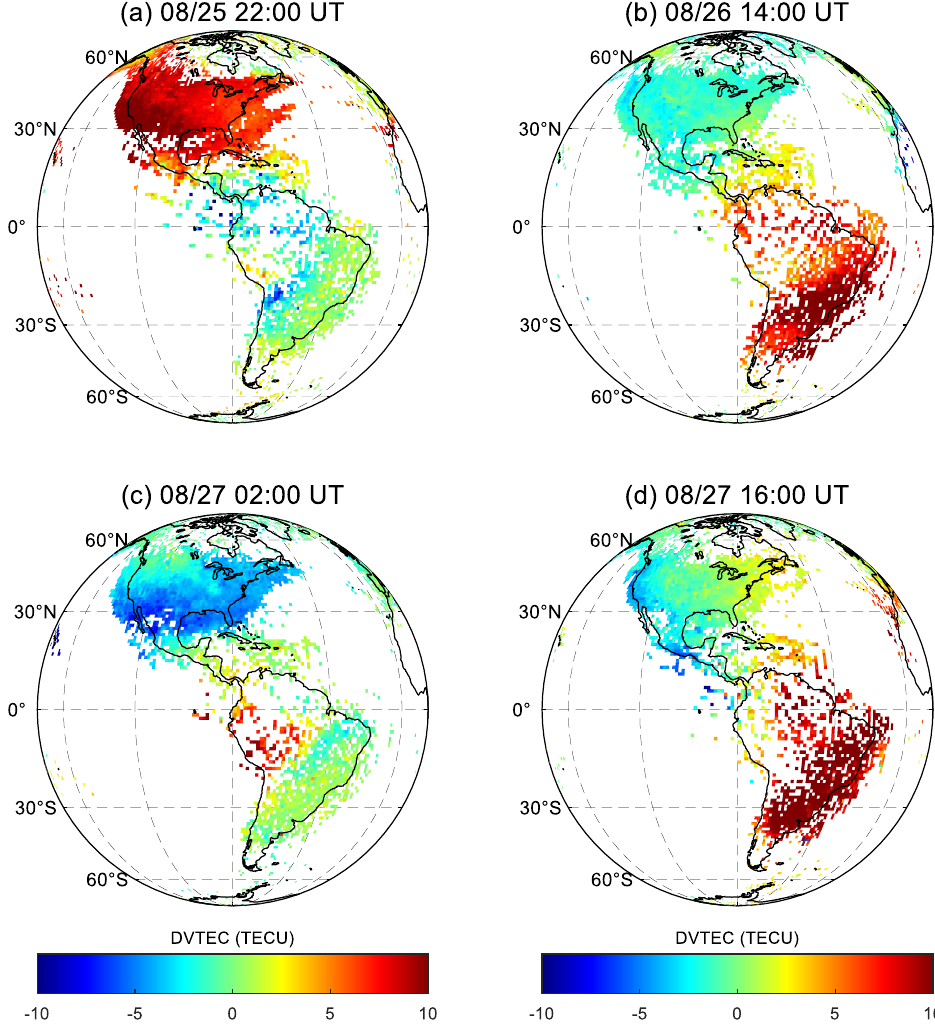
Figure 2. VTEC difference distribution over American sector between storm days (25 − 27 August) and quiet day (23 August).